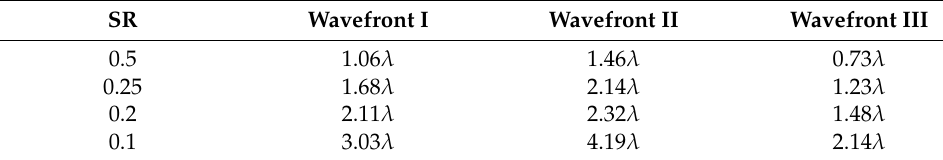
Table 3. Allowable PV values of original wavefront under SR requirements.